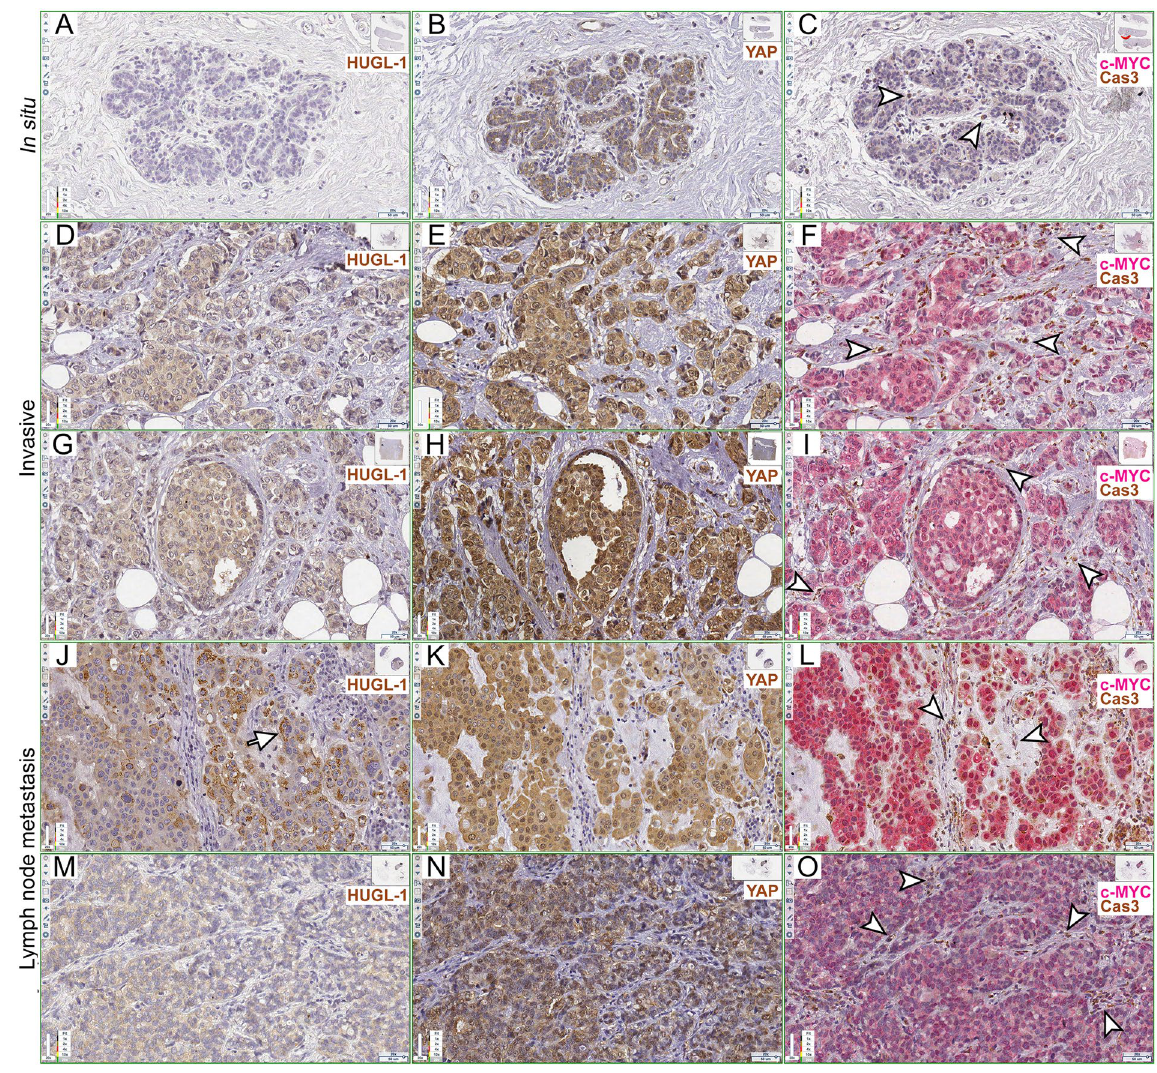
Figure 2. Apoptotic cell death at the tumour/stroma interface in human breast cancers. ( A – C ) HUGL-1 ( A ), YAP ( B ) and c-MYC/Cas3 ( C ) staining of an in situ carcinoma. The arrowheads in ( C ) highlight some stromal cells positive to Cas3 staining. ( D – I ) HUGL-1 ( D , G ), YAP ( E , H ) and c-MYC/Cas3 ( F , I ) staining of invasive carcinomas. The arrowheads in ( F and I ) indicate some stromal cells undergoing apoptotic death. ( J – O ) HUGL-1 ( J , M ), YAP ( K , N ) and c-MYC/Cas3 ( L , O ) staining of metastatic cancers. The arrow in ( J ) highlights a region of residual HUGL-1 protein localisation. The arrowheads in ( L and O ) indicate Cas-3 positive stromal cells. Scale bars are indicated in each